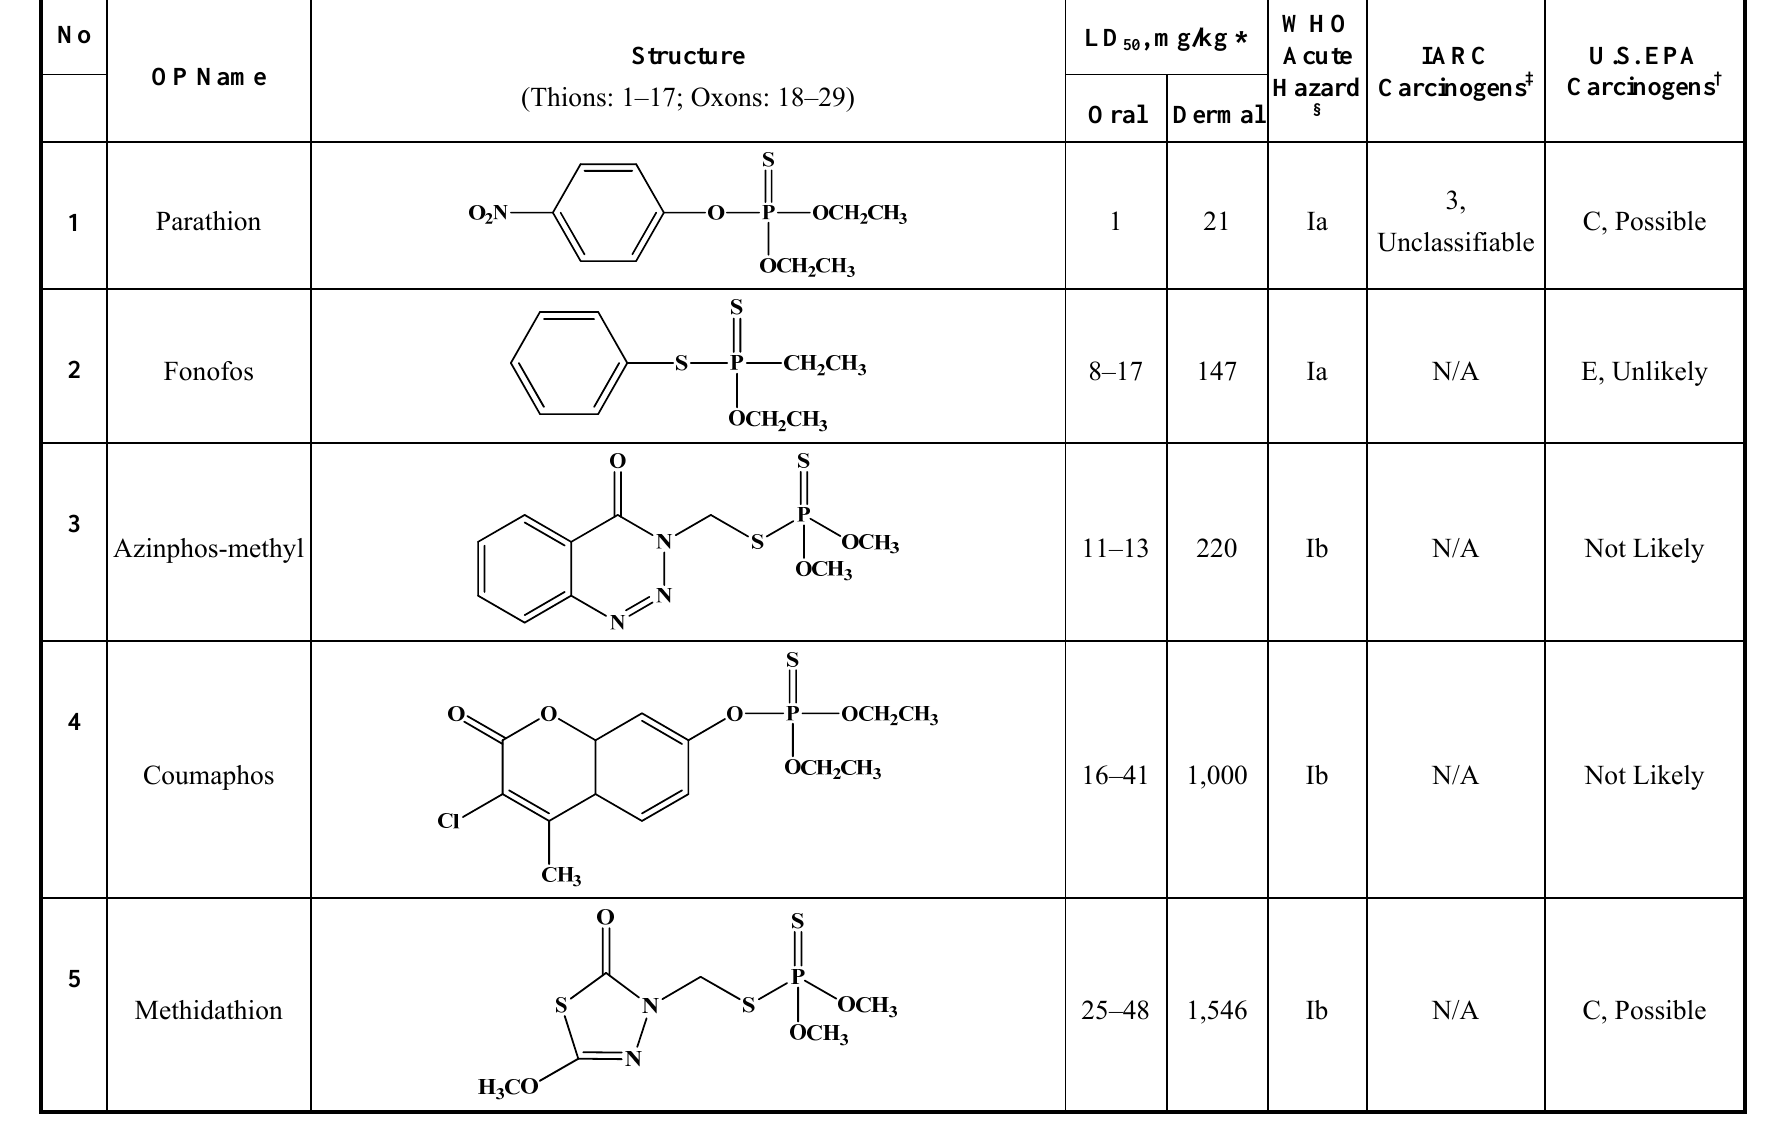
Table 1. Common OP pesticides classified by oxon/thion structure and oral LD